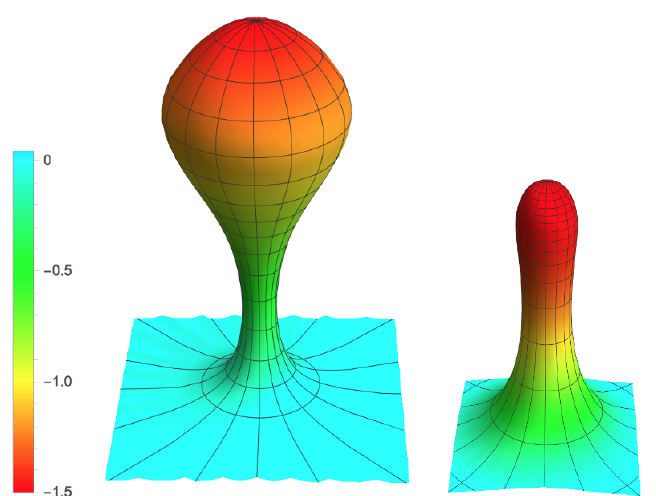
Figure 29 . This is a globule on the boundary (left), and on the horizon (right) for the values (cid:22) = 10 ; z = 1 : 5 ; (cid:23) = 6, embedded in hyperbolic space. The chemical potential (cid:8) (on the left) and p the electric (cid:12)eld E = (cid:0) j F yt F yt j (right), whose maximum denoted by the color red in the (cid:12)gure, occur at the tip (\spherical part") of the globule.